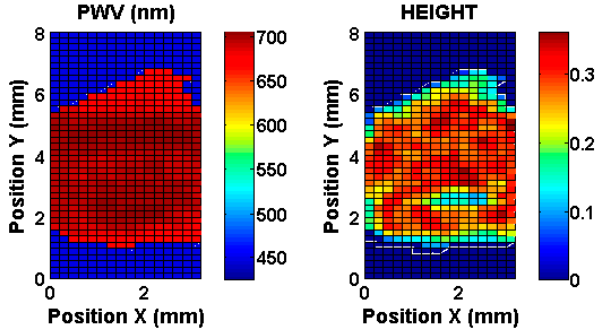
Figure 3. Left : Resonance wavelength in function of the (x, y) position; Right : the magnitude or depth of the resonant dip. The sensor is covered with